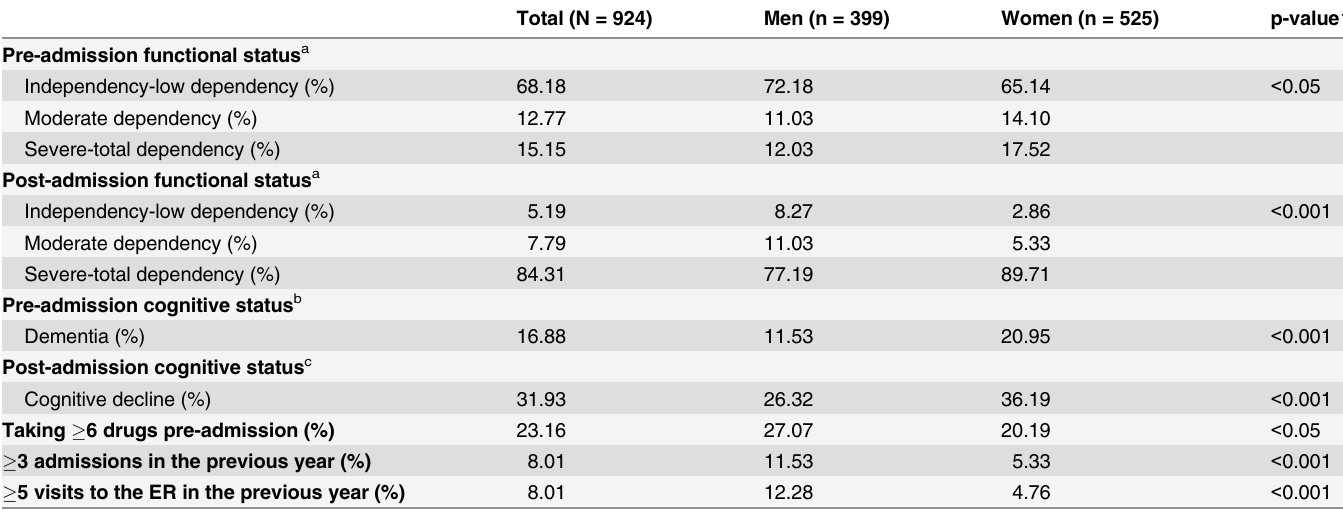
Table 2. Main characteristics of the study population. ER: emergency